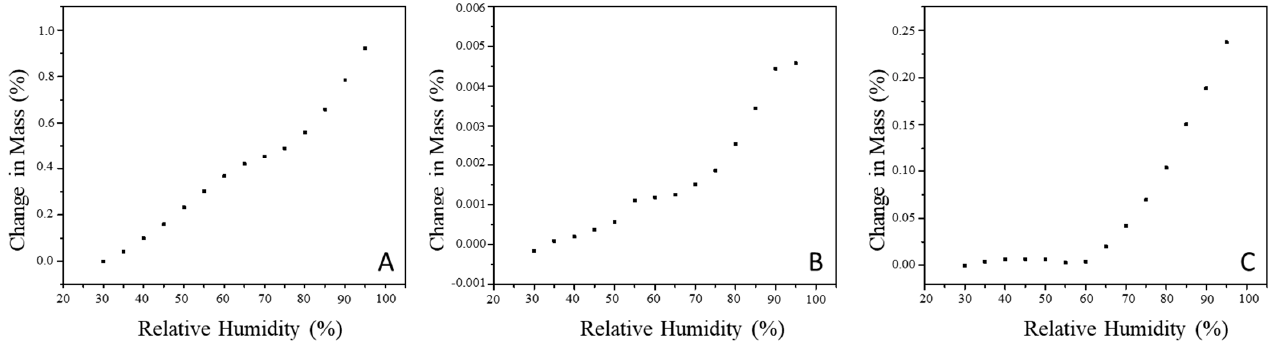
Figure 5. Sorption isotherms of microparticles obtained by ( A ) spray drying (SD33), ( B ) spray chilling (SC40), and ( C ) spray drying and chilling combination (SDC20). The numerical suffix denotes the core/carrier material ratio of the selected formulation.